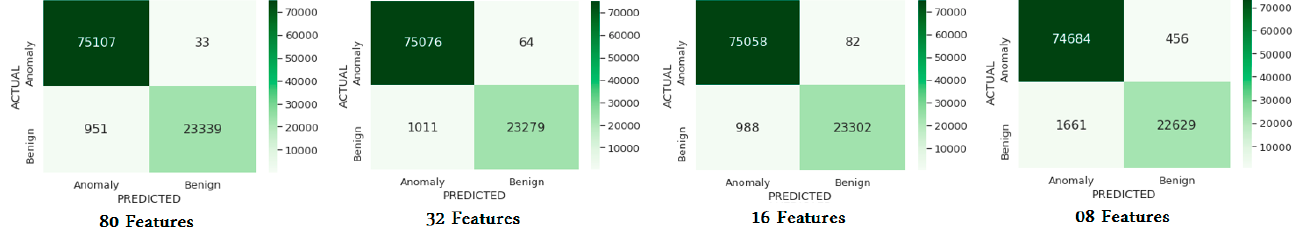
Figure 9. The confusion matrix of DNN-IDS methodology considering the different number of features.